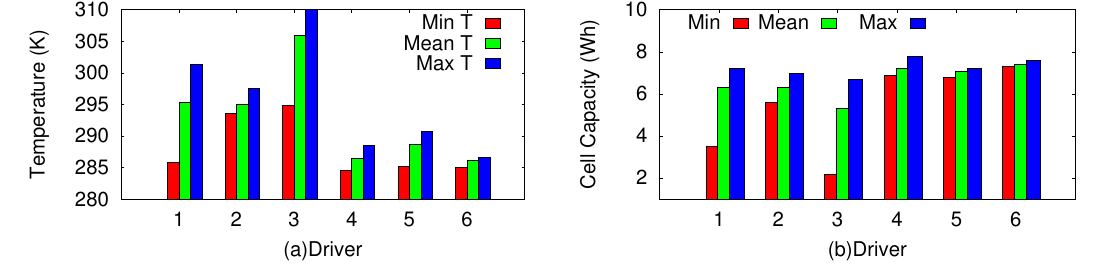
Figure 15. 15-year battery system thermal and capacity distribution of different